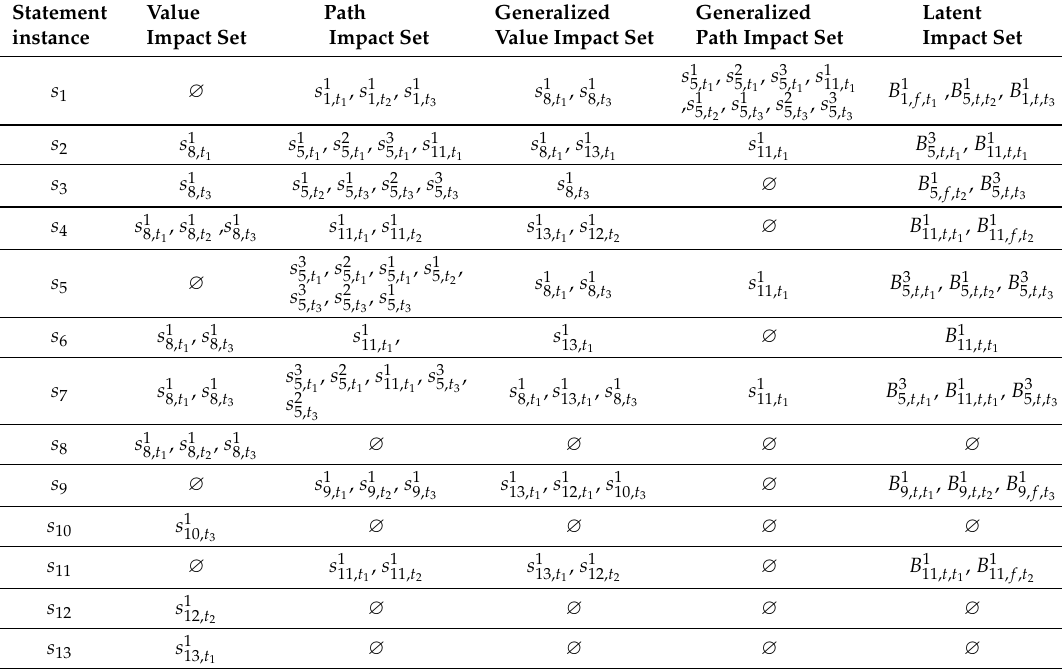
Table 4. The first five impact sets of all statements in Program 1.